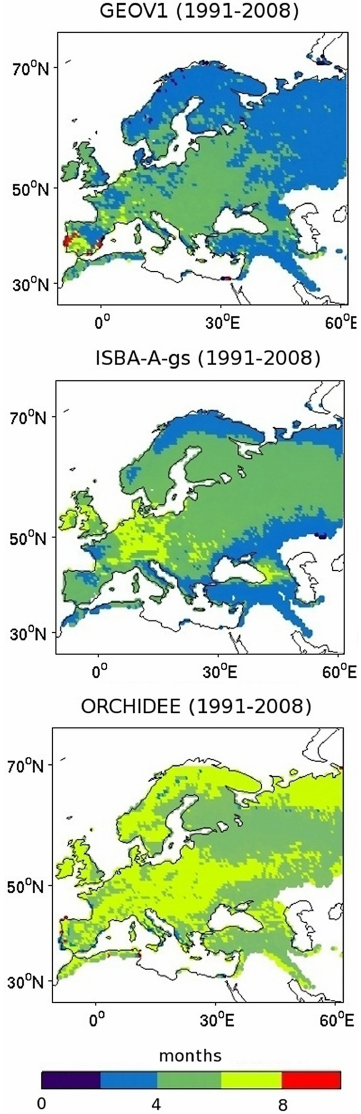
Figure 7. Same as Fig. 6, except for LGP